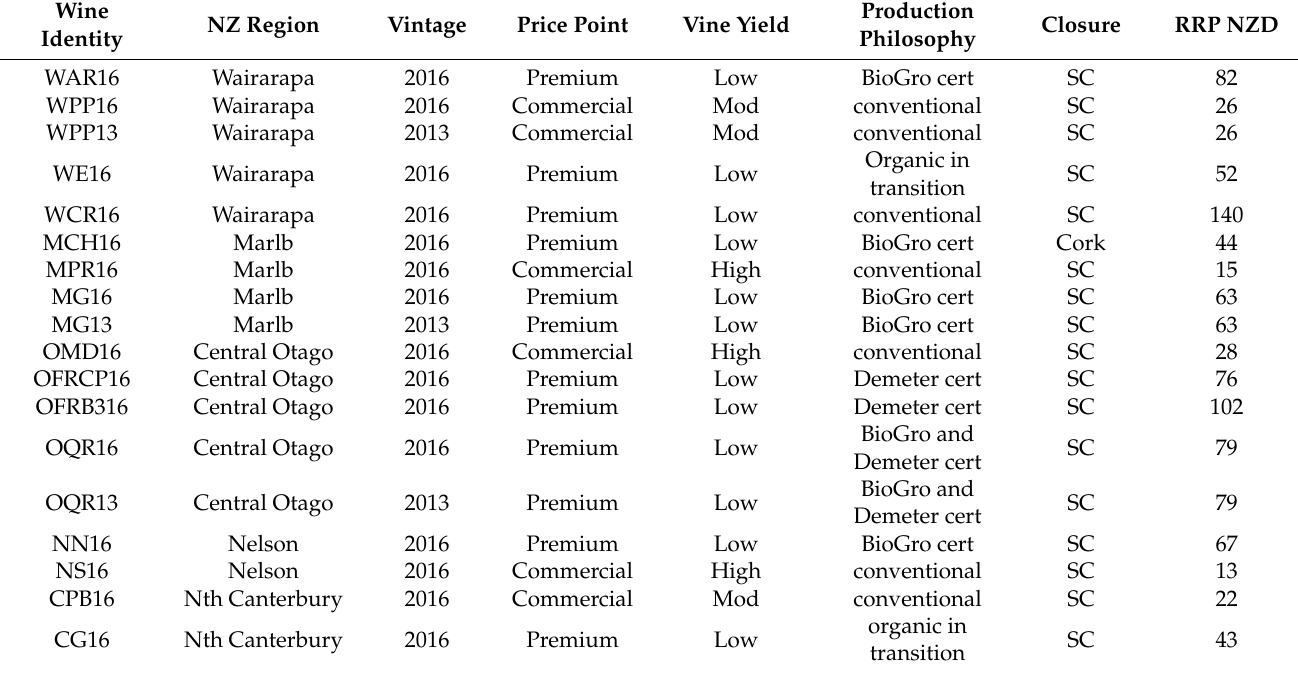
Table 1. The 18 wines employed in the two